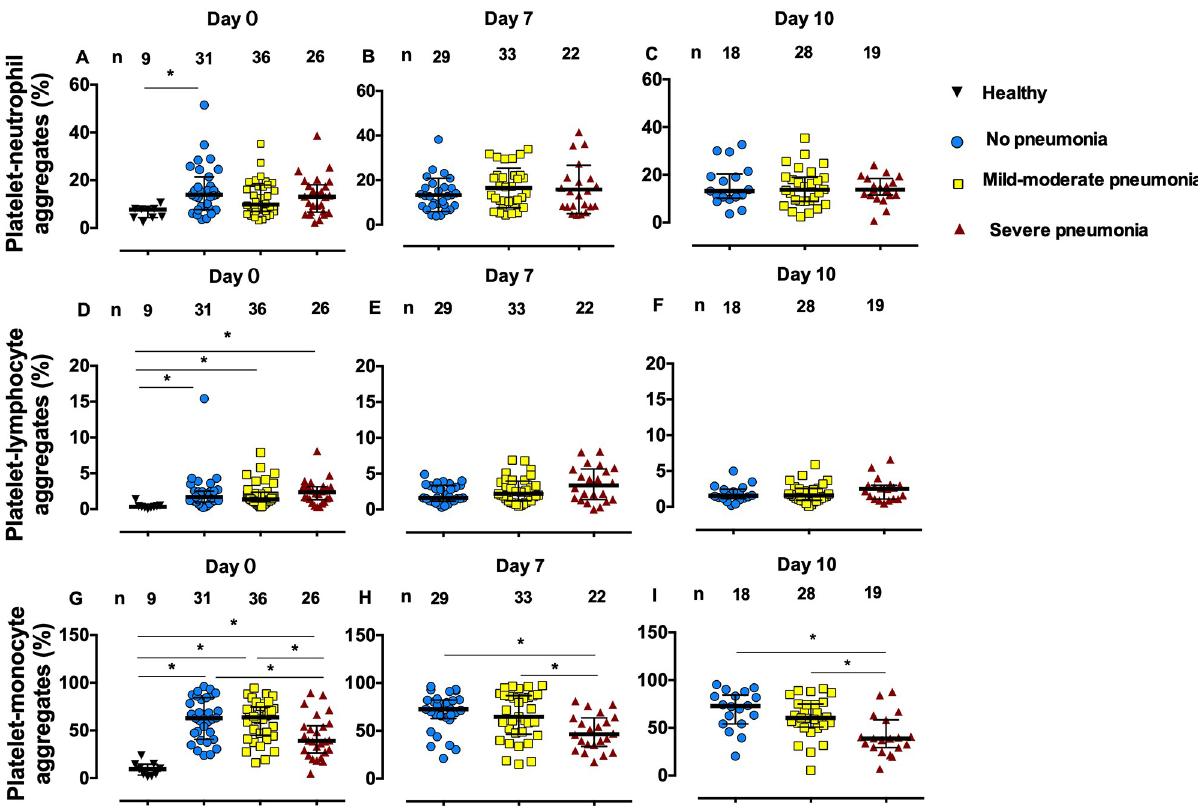
Fig 3. Platelet-neutrophil aggregates (A-C), platelet-lymphocyte aggregates (D-F), and platelet-monocyte aggregates (G-I) in healthy control subjects and COVID-19 patients on admission days 0, 7, and 10. Lines represent medians and interquartile ranges. � p < 0.05 by Kruskal-Wallis test.